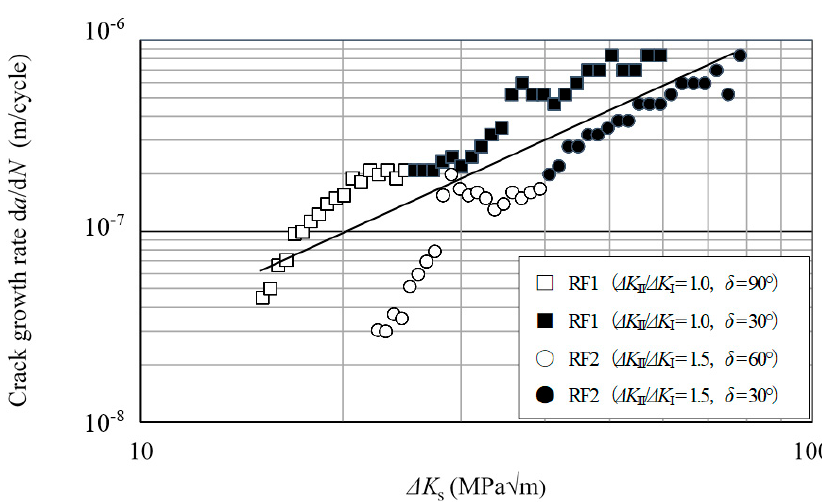
Figure 7. Coplanar crack growth rates against Δ K s for RP.